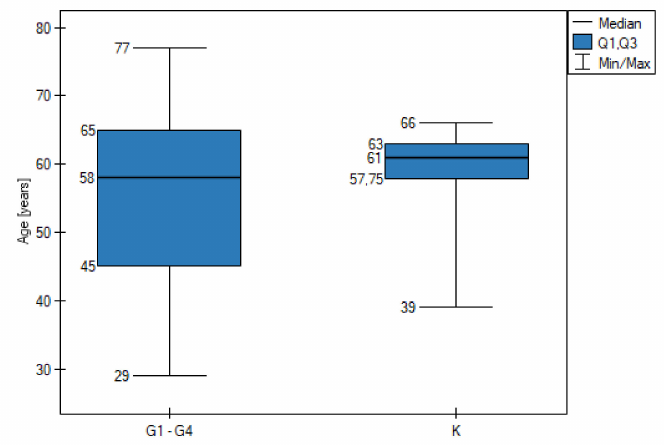
Figure A2. Age comparison of the patient population and the control group.